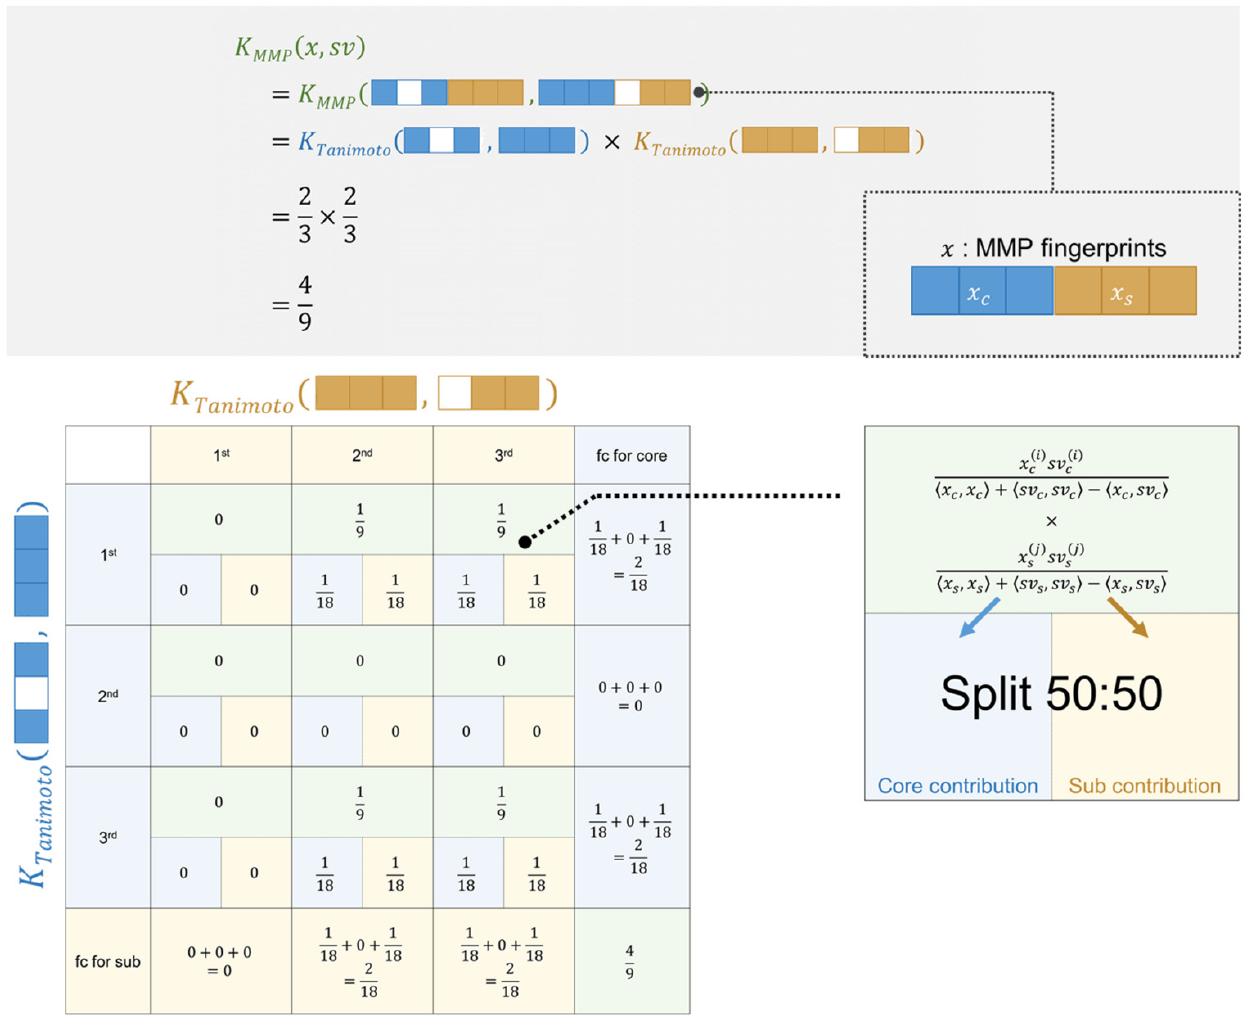
Figure 5. Assignment of feature contribution based on the MMP kernel. Shown above is an example of MMP kernel calculation and the assignment of feature contribution from a test MMP ( x ) and a support vector ( sv ) that has three features for the core and three features for substituents. Colored and uncolored squares represent features that are present and absent in MMPs, respectively. The MMP kernel is a product of the Tanimoto kernels of the fingerprints of the core (blue) and substituent (orange) parts that are divided from MMP fingerprints. Half of the cross-term feature weightings are assigned to the features in the core and half to the substituent features.